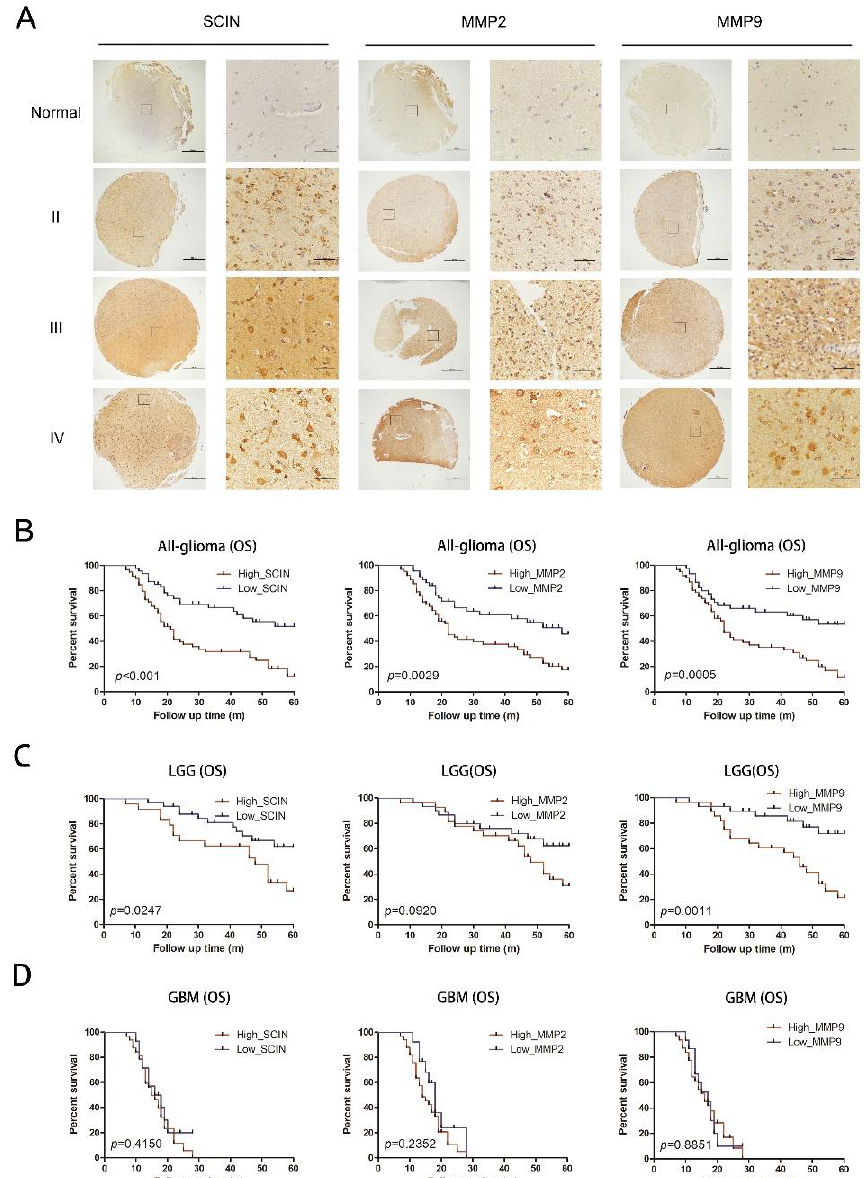
Figure 5. Expression of SCIN and MMP2/9 in glioma and Kaplan–Meier analysis. ( A ) The protein expression of SCIN, MMP2, and MMP9 in glioma and normal brain tissues through IHC (Scale of TAM: bar = 500 µ m, zoom in section: bar = 100 µ m). ( B ) The Kaplan–Meier OS curves in glioma patients provided significant differences between SCIN ( p < 0.001), MMP2 ( p = 0.0029) and MMP9 ( p = 0.0005). ( C ) OS analysis in LGG based on the expressions of SCIN ( p = 0.0274), MMP2 ( p = 0.0920), and MMP9 ( p = 0.0011) using Kaplan–Meier curves ( D ) OS analysis in GBM based on SCIN ( p = 0.415), MMP2 ( p = 0.2352), and MMP9 ( p = 0.8851). We also analyzed the effect of SCIN and MMP2/9 on the prognosis of glioma in our clinical samples. Univariate Cox analysis revealed that the expressions of SCIN (HR = 2.727, 95% CI = 1.608–4.625, Concordance Index = 0.622, p < 0.001), MMP2 (HR = 2.156, 95% CI = 1.273–3.650, Concordance Index = 0.595, p = 0.004), MMP9 (HR = 2.467, 95% CI = 1.442–4.220, Concordance Index = 0.58, p = 0.001), the WHO grade, and tumor diame- ter were risk factors in our clinical samples (Table 2). Multivariate Cox analysis showed that SCIN, MMP9, and the WHO grade were independently associated with survival in the clinical samples (Table